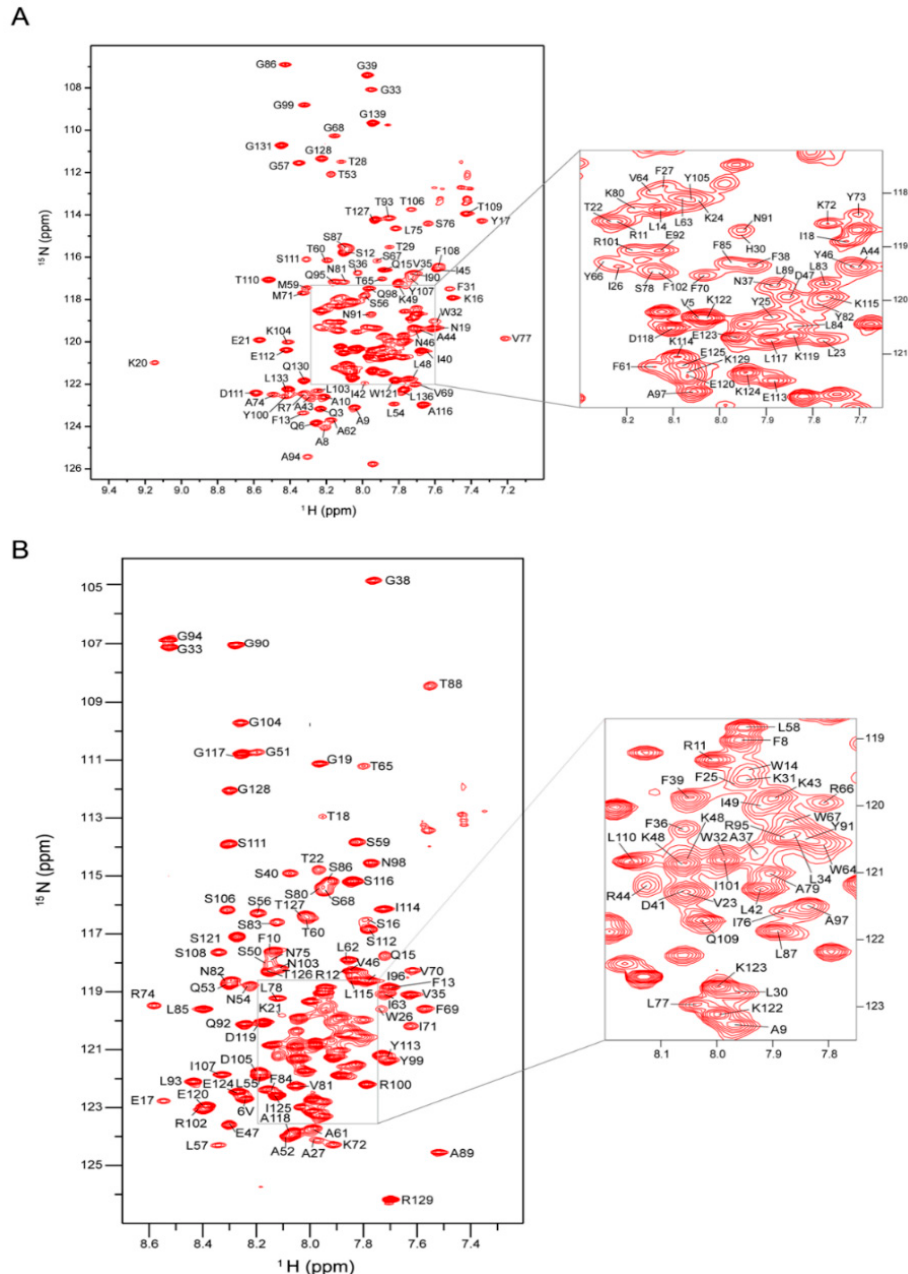
Figure 3. NMR spectra of yMPC1 and yMPC2 with backbone assignments. ( A ) 2D 1 H- 15 N TROSY- HSQC spectrum of yMPC1 in DPC micelles with backbone resonances assigned. The spectrum was recorded at 1 H frequency of 600 MHz using [ 15 N, 13 C, 2 H]-labeled protein. The crowded region is magnified on the right. ( B ) Two-dimensional 1 H- 15 N TROSY-HSQC spectrum of yMPC2 in DPC micelles with backbone resonances assigned. The spectrum was recorded at 1 H frequency of 600 MHz using [ 15 N, 13 C, 2 H]-labeled protein. The crowded region is magnified on the right.